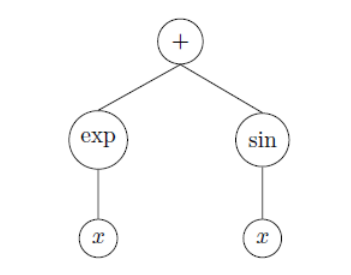
Figure 2. Tree that produces the expression M g (x) = exp(x) + sin(x) The first and second order derivatives for this expression and are 𝑔𝑔1 ( 𝑥𝑥 ) = exp( 𝑥𝑥 ) + 𝑐𝑐𝑃𝑃𝑐𝑐 ( 𝑥𝑥 ) 𝑀𝑀 sin ( 𝑥𝑥 )